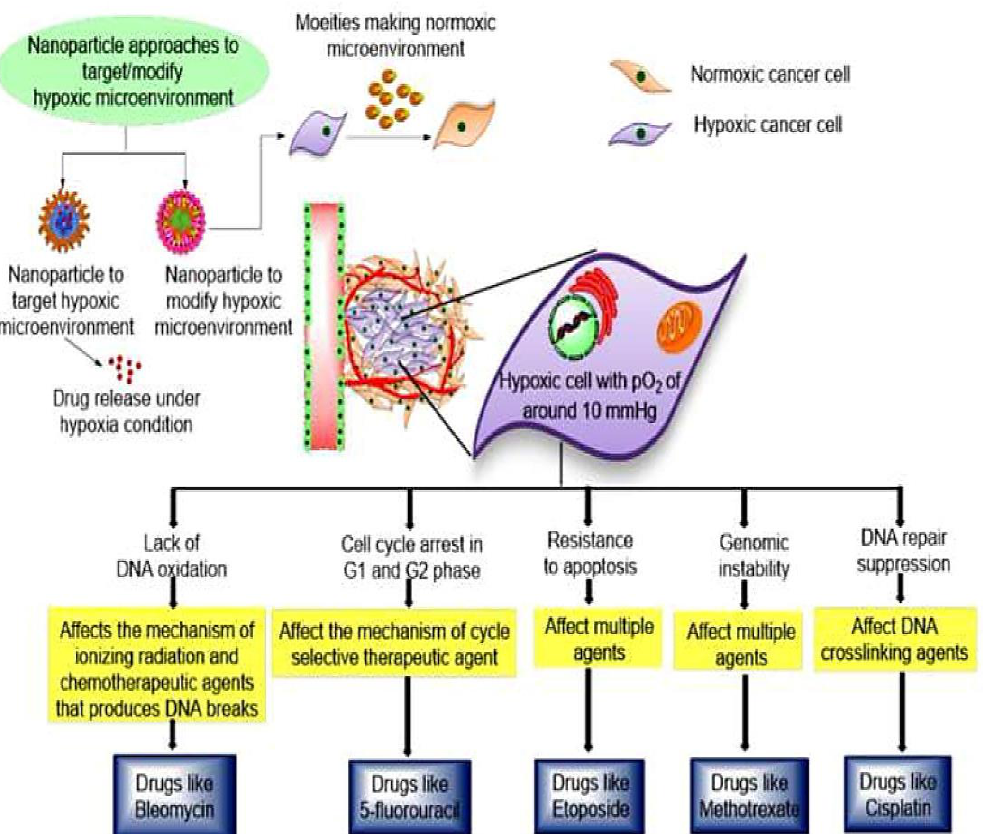
Figure 7. Cancer nanotherapeutics approaches to counter hypoxic conditions within tumor microen-